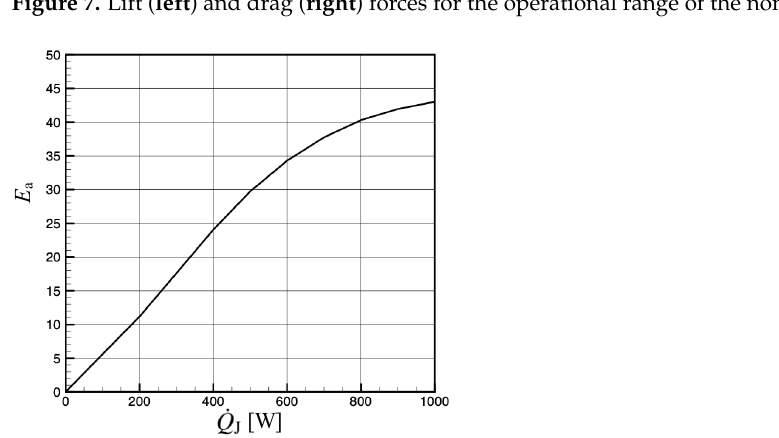
Figure 7. Lift ( left ) and drag ( right ) forces for the operational range of the nominal power feed ˙ Q J .